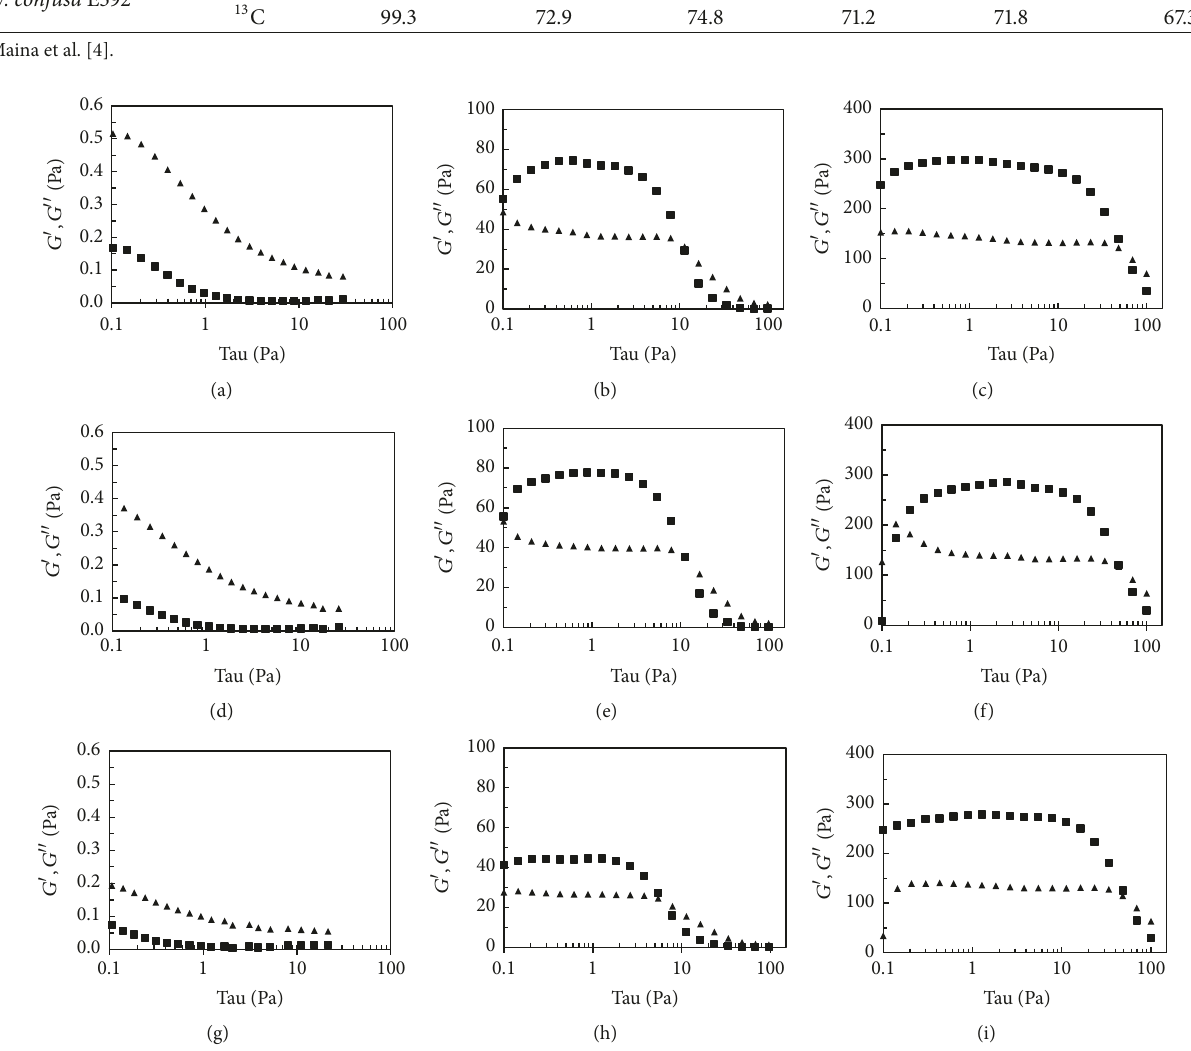
Figure 5: Elastic moduli, 𝐺 󸀠 ( ◼ ), and viscous moduli, 𝐺 󸀠󸀠 ( 󳵳 ), as a function of shear of the purified dextran from W. confusa R003: (a) 2.5% w/v, 25 ∘ C; (b) 5.0% w/v, 25 ∘ C; (c) 10.0% w/v, 25 ∘ C; (d) 2.5% w/v, 37 ∘ C; (e) 5.0% w/v, 37 ∘ C; (f) 10.0% w/v, 37 ∘ C; (g) 2.5% w/v, 50 ∘ C; (h) 5.0% w/v, 50 ∘ C; (i) 10.0%w/v, 50 ∘